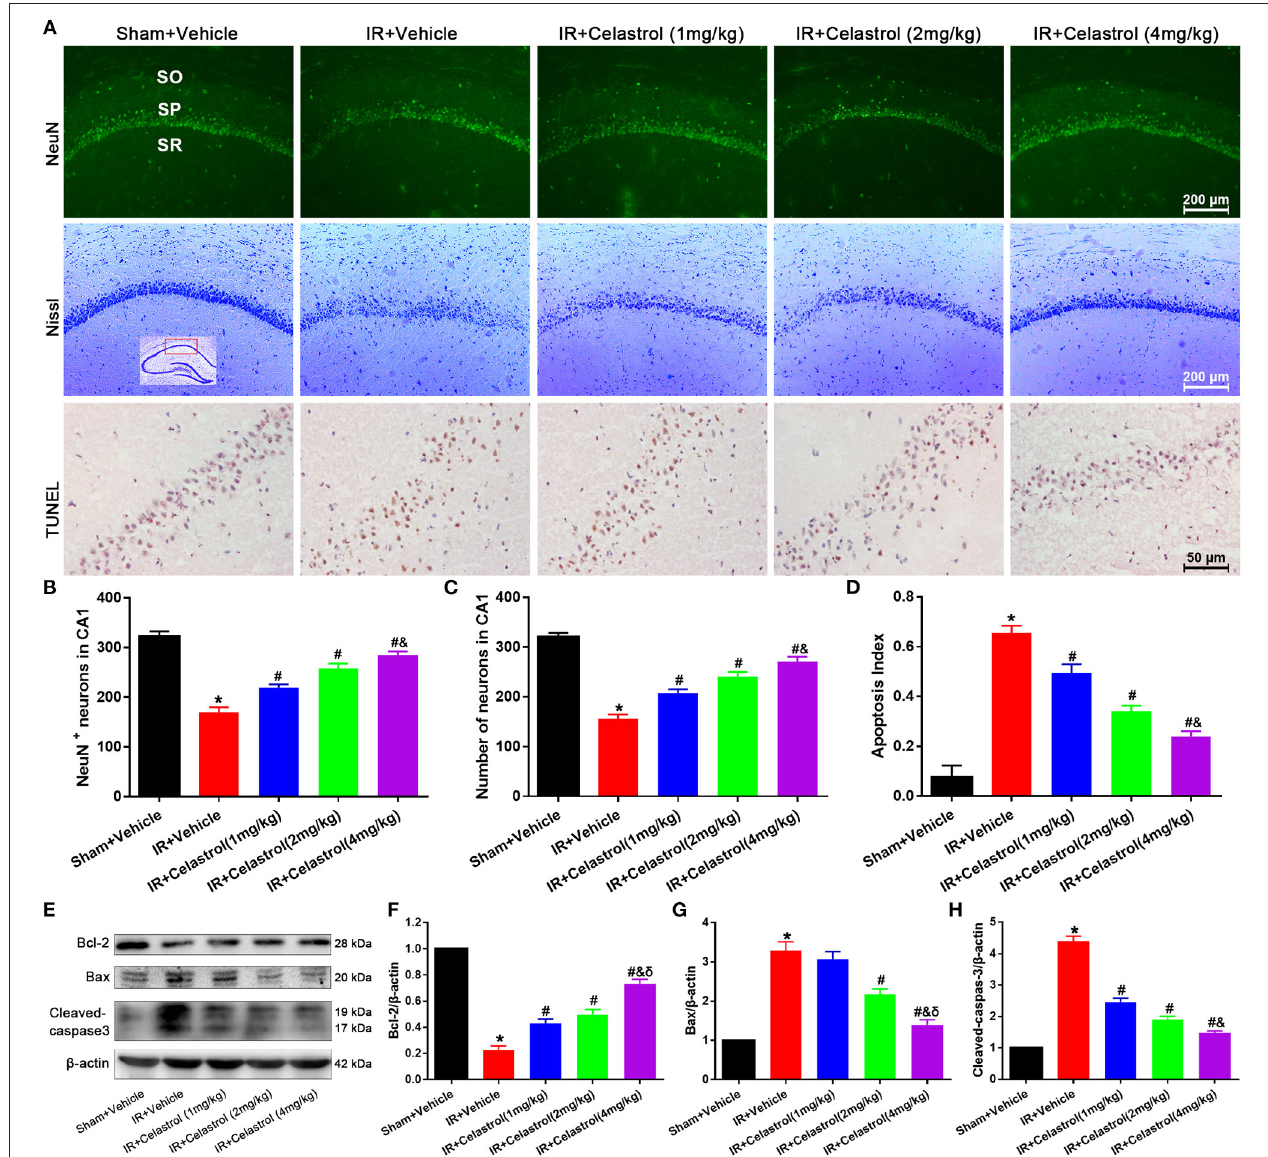
FIGURE 2 | Celastrol inhibits apoptotic hippocampal neuronal death. (A) Representative images of NeuN immunofluorescent staining sections (first row), cresyl violet-stained sections (second row) and TUNEL-stained sections (third row) in hippocampal CA1 region of tGCI/R rats, the built-in schematic diagram with red rectangular shows the area that we analyzed. Data were obtained from 4 independent animals, and the results of a typical experiment are exhibited. Scale bar = 200 µ m. SO, stratum orients; SP, stratum pyramidal; SR, stratum radium. (B) Quantitative analysis of NeuN positive neurons. (C) Quantitative analysis of Nissl-positive neurons (D) The apoptosis index of hippocampal CA1 neurons. (E–H) Western blot analysis of apoptosis-related proteins Bcl-2, Bax and cleaved-caspase-3, β -actin was used as an internal control. The error bars represent mean ± S.E.M ( n = 4, * P < 0.05 vs. Sham + Vehicle group; # P < 0.05 vs. IR + Vehicle group; & P < 0.05 vs. IR + Celastrol (1 mg/kg) group; δ P < 0.05 vs. IR + Celastrol (2 mg/kg)